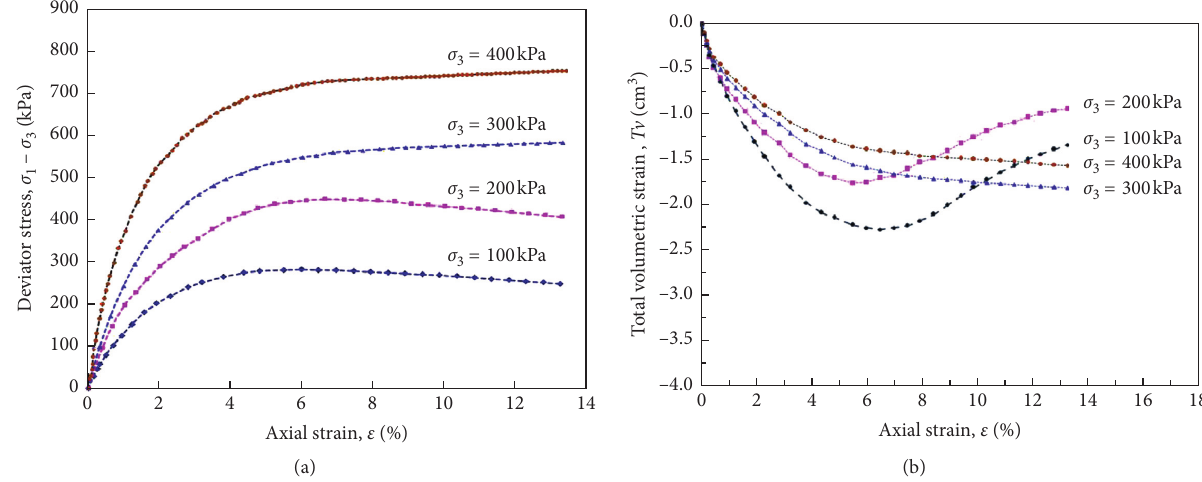
Figure 5: Stress-strain-volume change curves of the CDG soil: (a) deviator stress versus axial strain; (b) total volumetric strain versus axial strain.